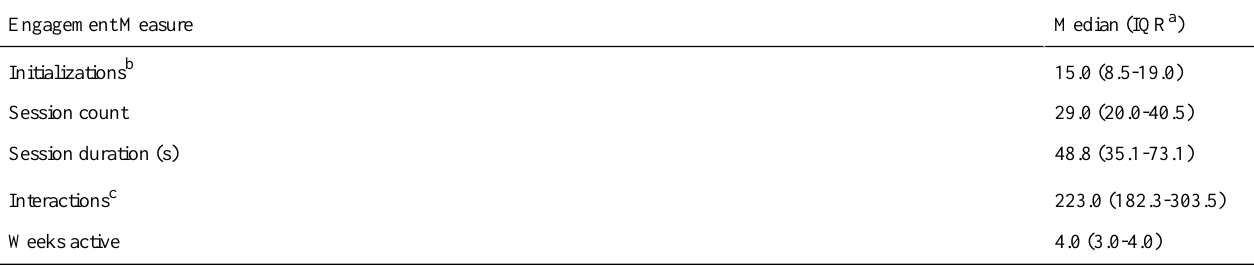
Table 2. Engagement measures over the study period per participant.